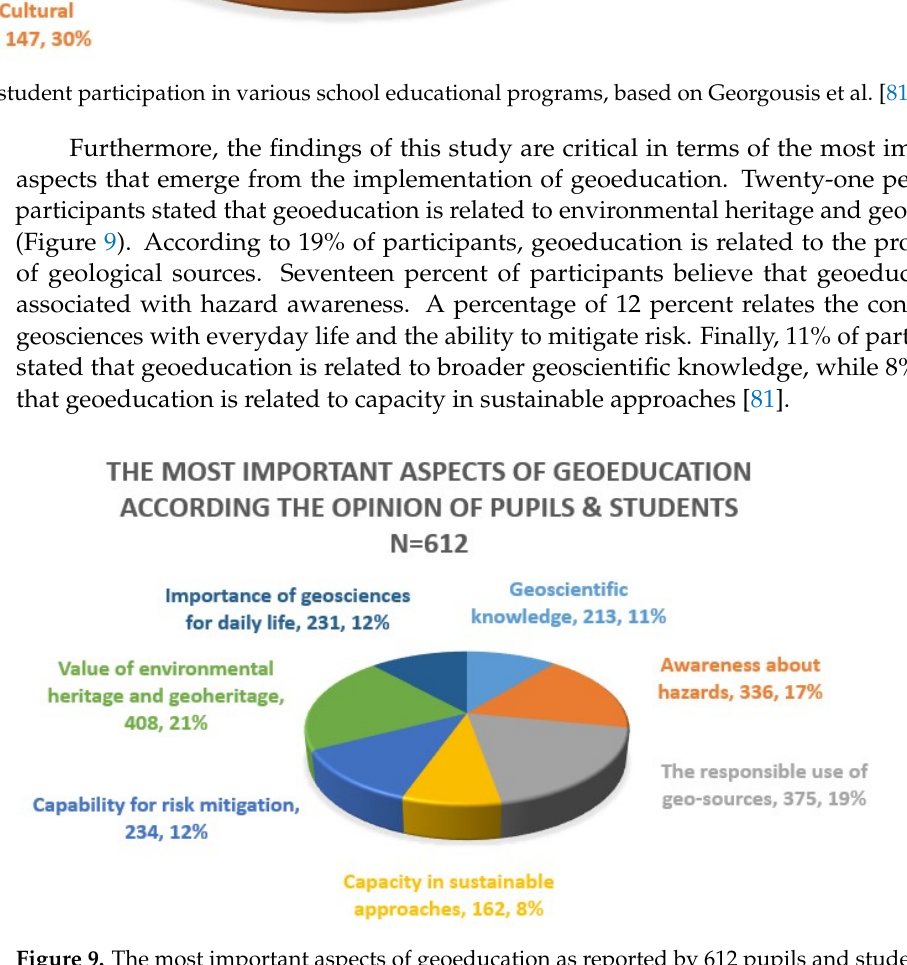
Figure 9. The most important aspects of geoeducation as reported by 612 pupils and students